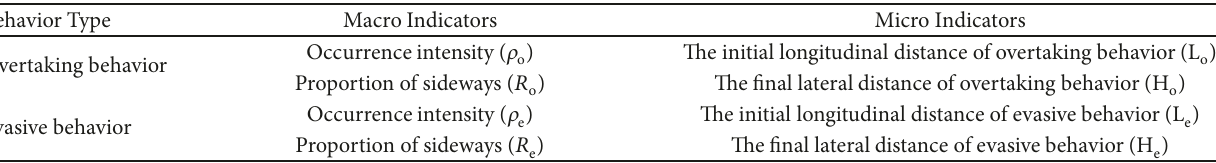
Figure 4: Schematic drawing of PIBs. Table 2: Macro and micro indicators of PIB